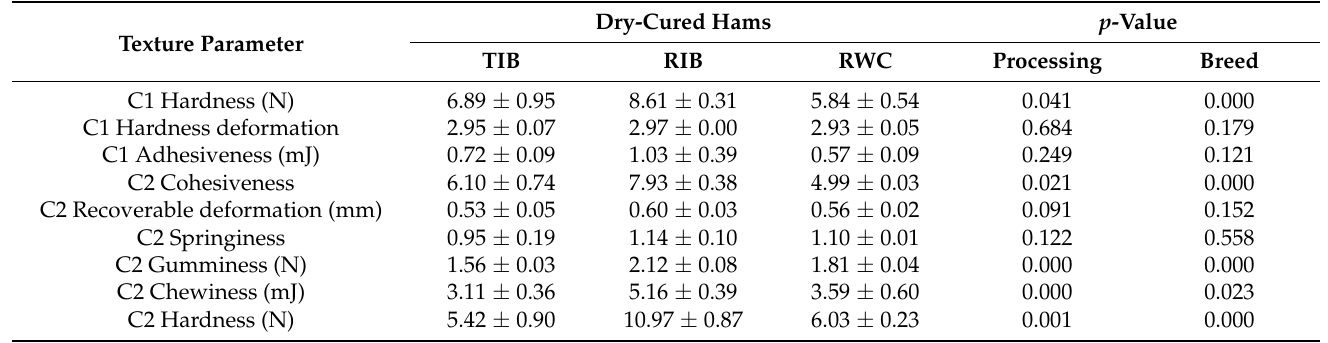
Table 5. Effect of Iberian dry-cured ham type (processing) and effect of breed on instrumental texture. Results are expressed as mean values ±